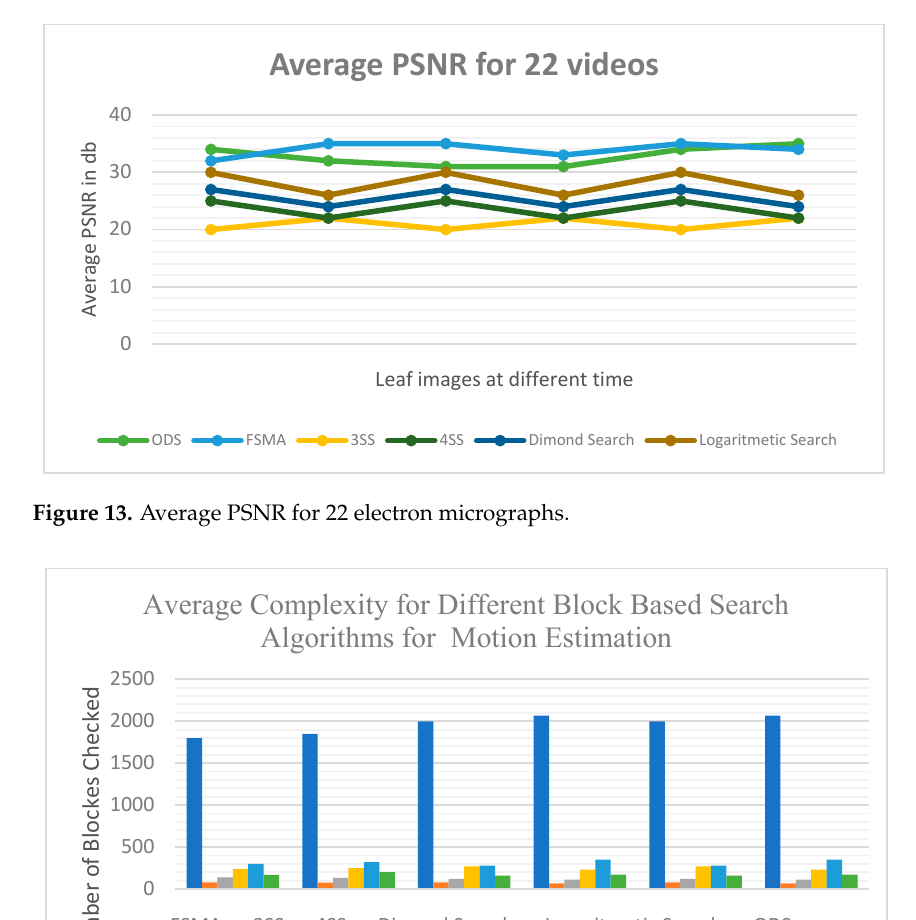
Figure 12. Average versus absolute differences in degree of crystallization of the upper surface crop for 22 calcium oxalate crystals.